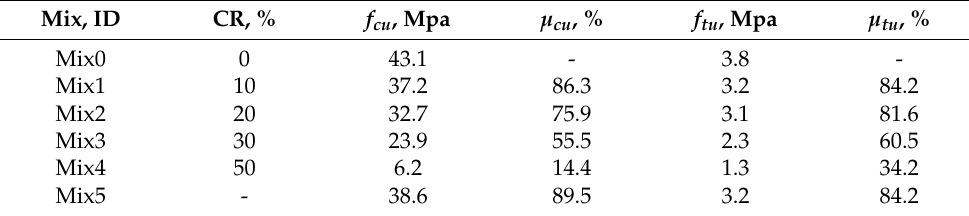
Table 5. Compressive and tensile strength of concrete with and without crumb rubber. Mix, ID CR, % f cu , Mpa µ cu ,